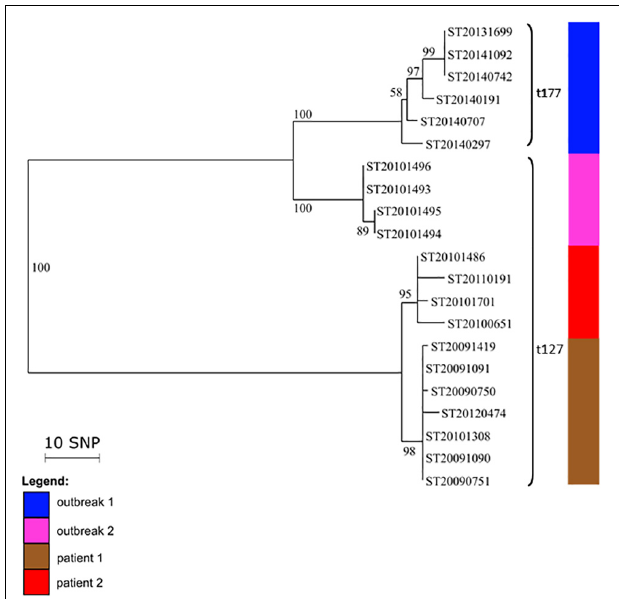
FIGURE 2 | Intra- and inter-patient evolution of PVL-positive CC1 MSSA isolates responsible for outbreaks and sporadic infections. Neighbor-joining tree of 19 PVL-positive CC1 MSSA isolates that were implicated in outbreaks in a home for mentally disabled patients (outbreak 1) and in a prison (outbreak 2), and in recurrent infections in two patients (patient 1 and patient 2). The node numbers are bootstrap scores based on 100 repetitions. The scale represents the number of SNPs in 1,328 core